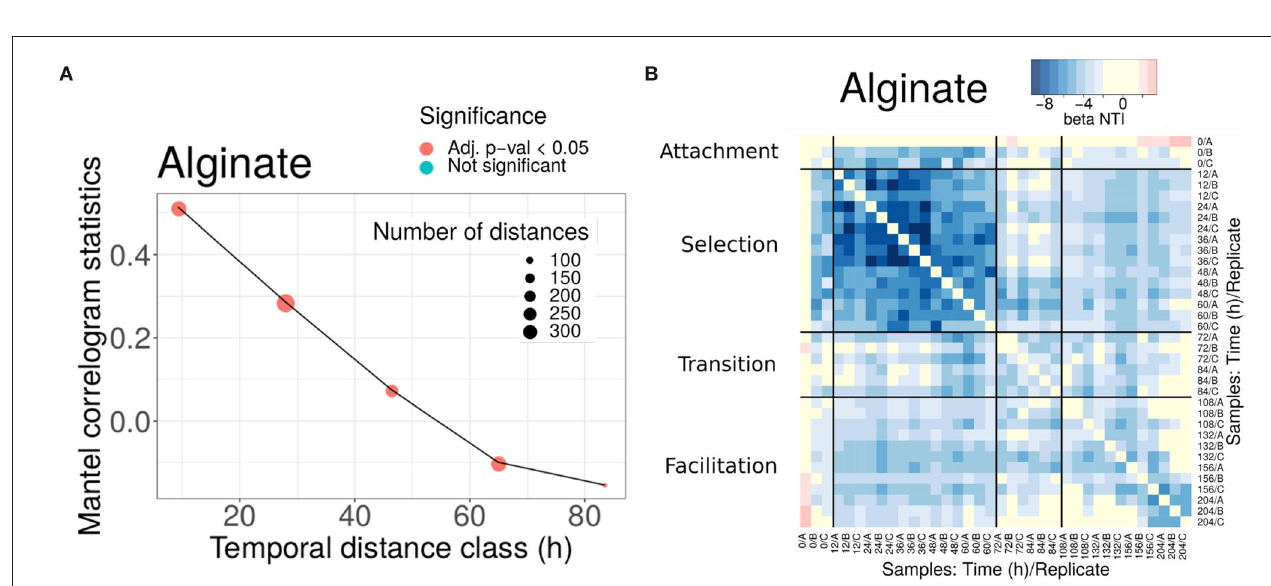
FIGURE 2 | Number of optimal classes and test of neutrality. (Left) The optimal number of classes (number of Dirichlet mixture components) is determined by the minimum of the posterior evidence of the fit. Results are for alginate. (Right) Main time intervals are determined by each class in single substrates. The time window is determined considering consecutive samples classified in the same class (i.e., sparse samples misclassified are non-indicated, see Figure 1 for details). For chitin, the whole interval is indicated since no clear time-windows are defined. Pseudo p -values of the HDP test for each class found in pure substrates for the complete and local models are indicated.